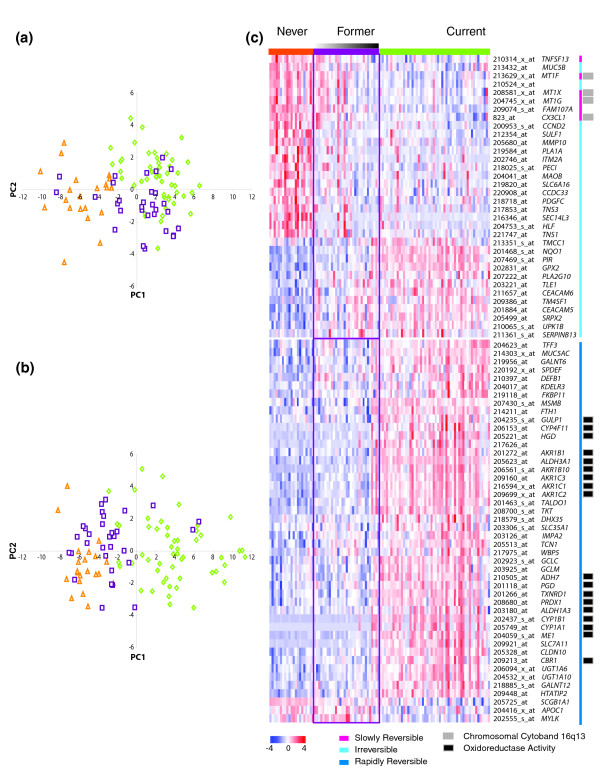
Relationship between samples according to the expression of genes with different reversibility characteristics. PCAs are shown on the left for (a) the slowly reversible and irreversible genes (n = 34) and (b) the most rapidly reversible genes (n = 46). (c) False-color heatmaps are shown on the right for the slowly reversible and irreversible genes (top) and the most reversible tertile of rapidly reversible genes (bottom). Never, former, and current smokers are colored in orange, purple, and green respectively. The PCA and heatmaps were constructed using gene expression data normalized to a mean of zero and a standard deviation of 1. Never and current smokers are organized according to increasing age and former smokers are ordered by decreasing time since quitting smoking (denoted by the gradient) along the sample axis in the heatmap. Affymetrix identifications and HUGO gene symbols are listed for each gene as well as membership in two over-represented functional categories by EASE analysis.